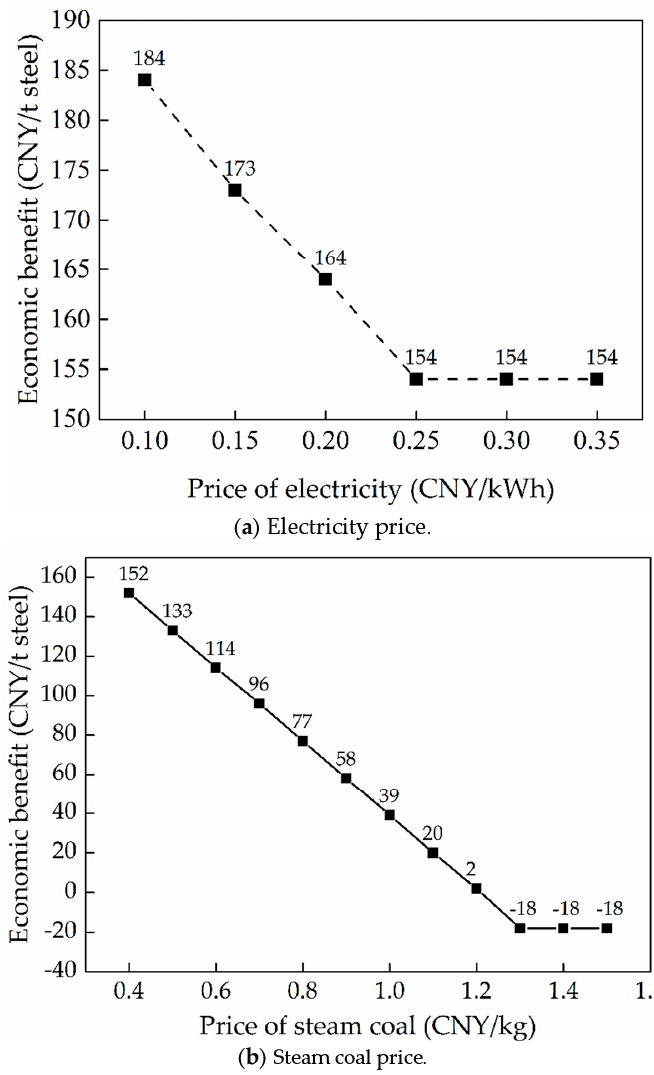
Figure 5. The effects of the steam coal price and electricity price on the economic benefit of the energy system.